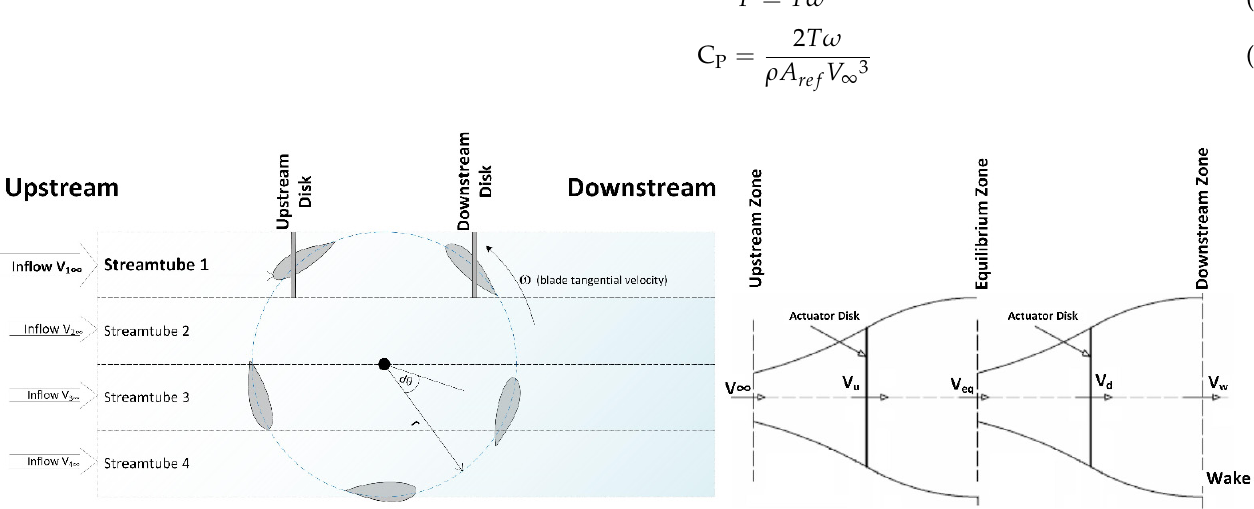
Figure 3. Double multiple stream tube